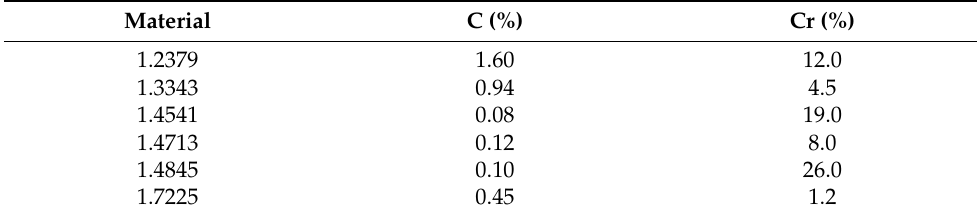
Table 9. Elemental structure selected from Table 5 for steels presented in Table 8 and Figure 5.